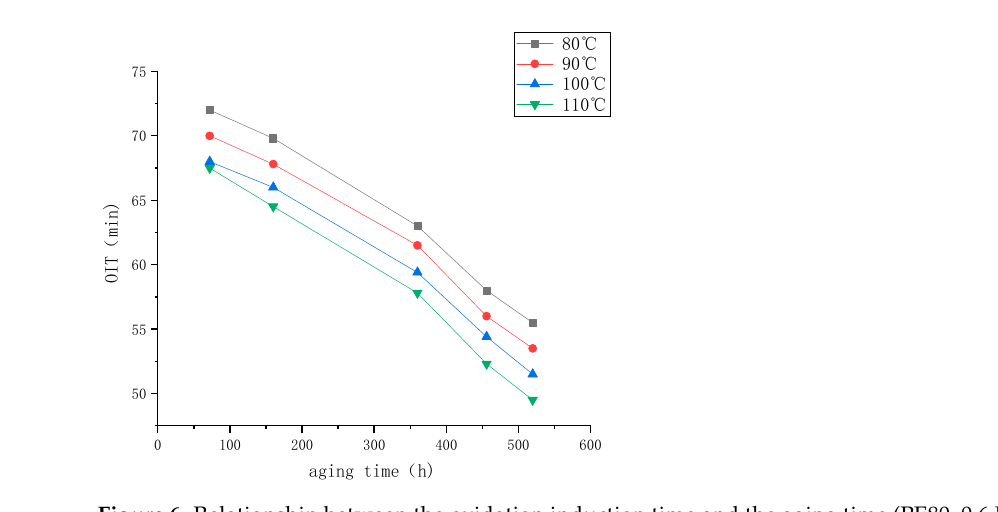
Figure 6. Relationship between the oxidation induction time and the aging time (PE80, 0.6 MPa).